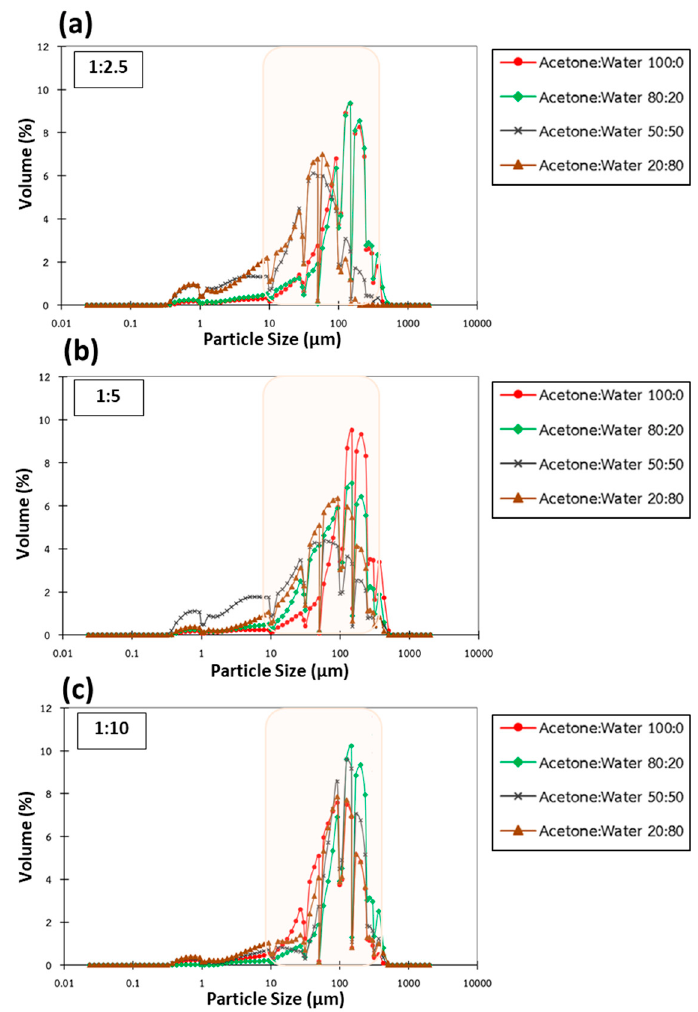
Figure 3. Particle size distribution profiles of cenospheres collected from using di ff erent ratios of freshly prepared acetone–water mixtures, a 4-h soaking period, and fly ash / medium ratios of ( a ) 1:2.5, ( b ) 1:5, and ( c ) 1:10.